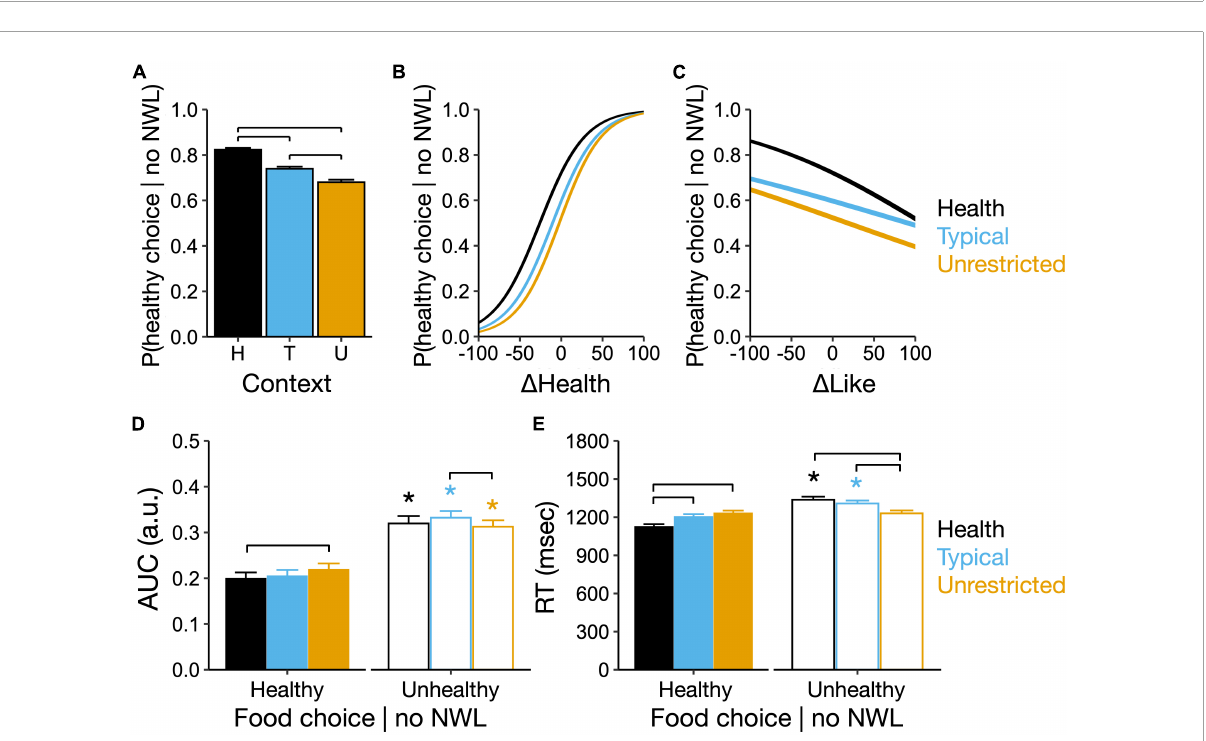
FIGURE3 Eating contexts determine the probability of healthy choices and the magnitude of conflict during food choices made in the absence of nutrient warning labels (NWL). (A) Probability of healthy food choice made without showing NWL by context. Brackets, P < 0.05 for pairwise comparisons. (B) Larger differences in subjective health rating (fixing like differences at 0) between food images increase the probability of a healthy choice made without showing NWL in all contexts. (C) Larger differences in subjective like rating (fixing health differences at 0) between food images reduce the probability of healthy choices made without showing NWL in all contexts. For panels (B,C) , differences in health and like ratings were calculated relative to the chosen food image. (D) AUC and (E) RT during healthy and unhealthy food choices made without showing NWL. Brackets, P < 0.05 pairwise differences between contexts within healthy and unhealthy choices. Asterisks, P < 0.05 between healthy and unhealthy choices within contexts.